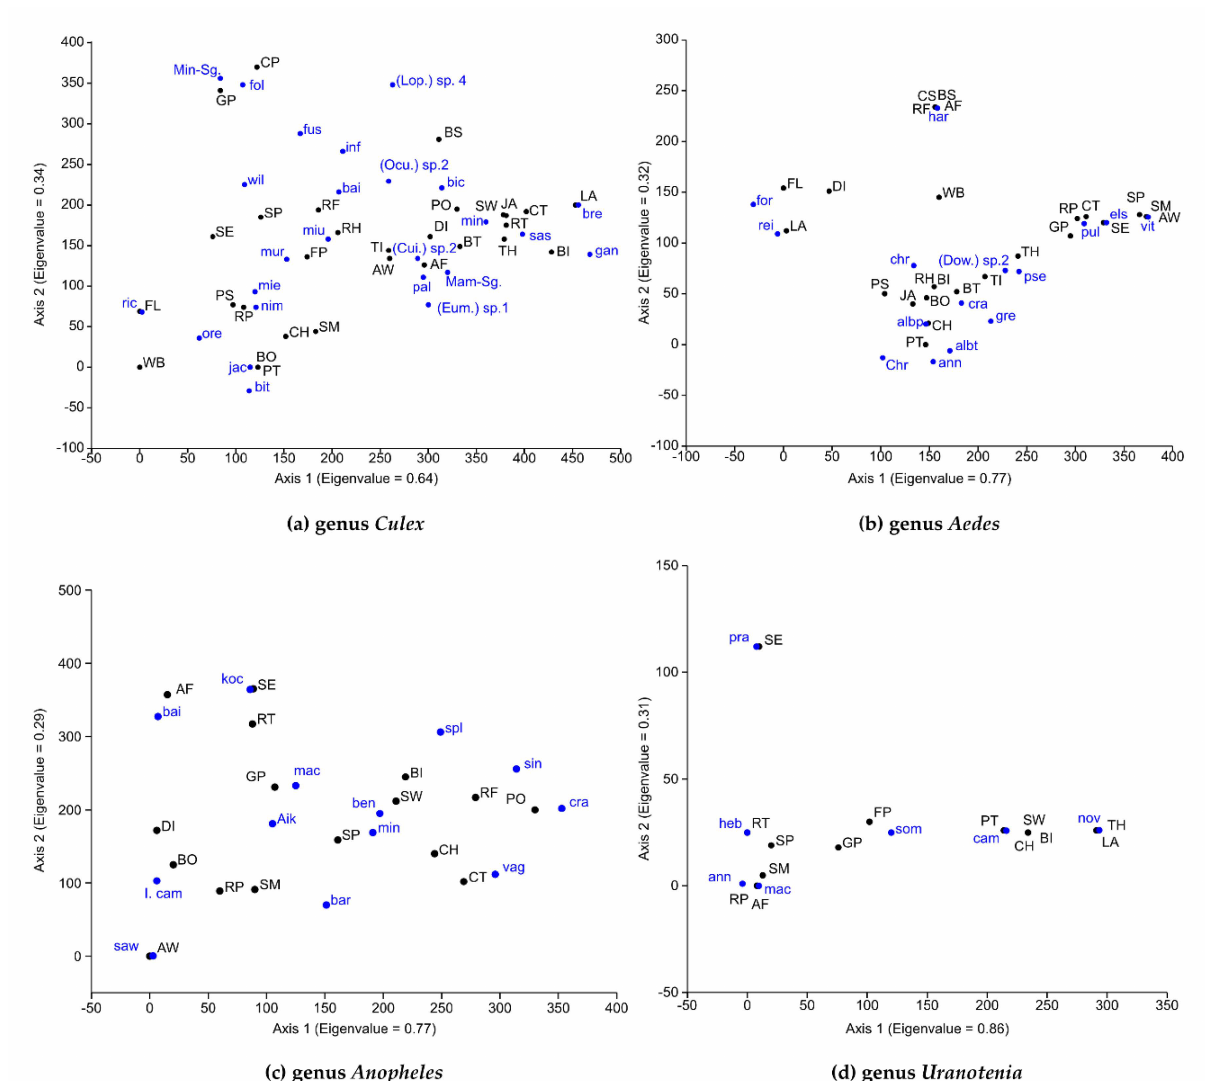
Figure 11. Multivariate ordination of detrended correspondence analysis (DCA) of mosquito species of four dominant genera which correlated to habitat types in Doi Inthanon National Park. ( a ) Culex , ( b ) Aedes , ( c ) Anopheles , and ( d ) Uranotaenia . Blue letters = mosquito species; black letters = habitat type. Abbreviations of mosquito species and types of habitats are given in Table